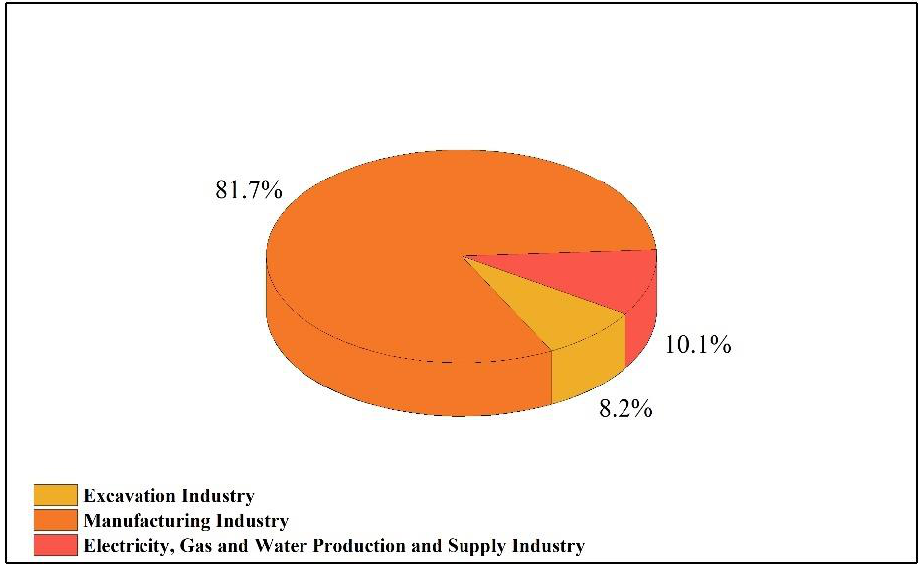
Figure 3. Proportion of CO 2 emissions in the excavation, manufacturing, electricity, gas and water production, and supply first-layer subsectors.